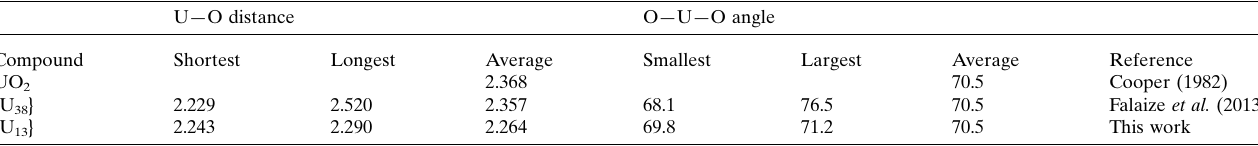
Table 2 Geometrical parameters (A˚ , (cid:5) ) of cubic uranium polyhedra in different compounds. U—O